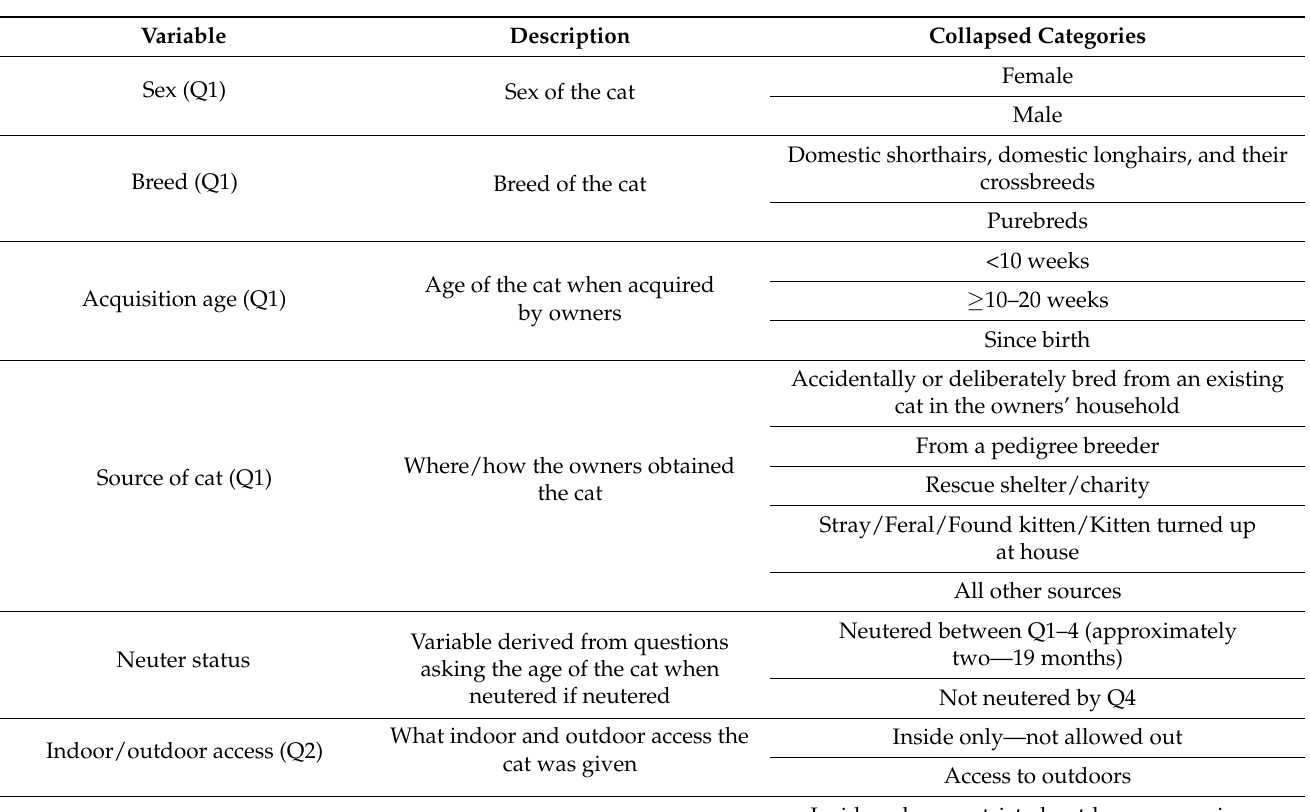
Table 1. Variables assessed as potential risk factors for owner-reported chronic